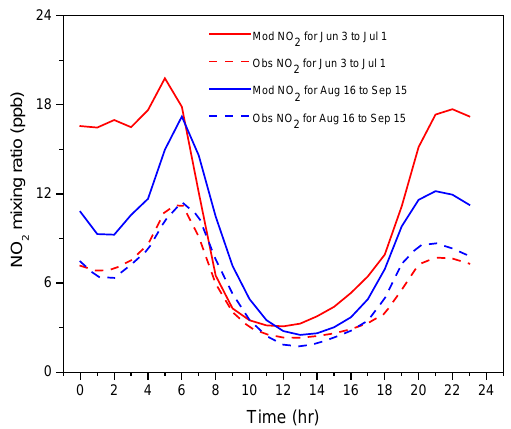
Fig. 6. Daily variations of modeled (solid line) and observed (dashed line) ground NO 2 concentrations for the June (red) and August–September (blue) episodes. Note: NO 2 concentrations were taken by averaging monthly data for all